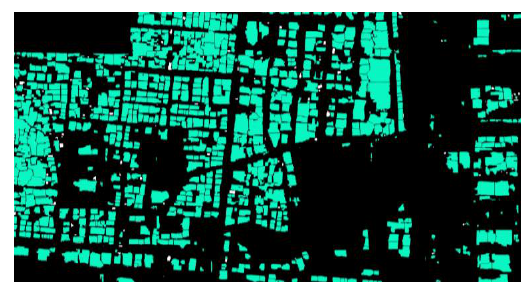
Figure 2 . 5 : Watershed Segmentation output